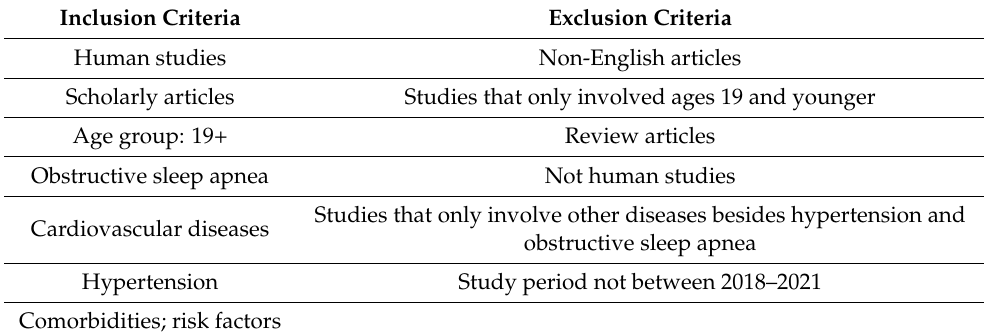
Table 1. Inclusion and Exclusion